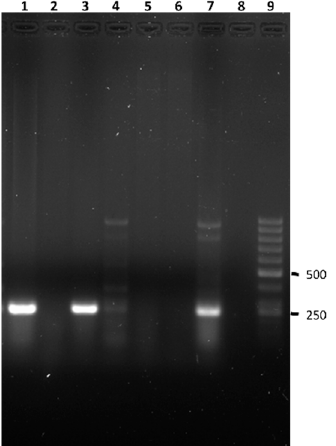
Figure 3. Results of the m-PCR assay for the simultaneous detection of Pseudomonas spp. and P. aeruginosa from the Anolis sp. analyzed. Lane 1 and 3, amplification fragment of the oprI gene characteristic of Pseudomonas sp. obtained from Anolis sp. analyzed in this study. Lane 2, 4, 5, and 6, Anolis sp. negative for Pseudomonas sp. Lane 7, positive control. Lane 8, control negative. Lane 9, molecular size marker (GeneRuler 50 bp DNA Ladder, Thermo Scientific).